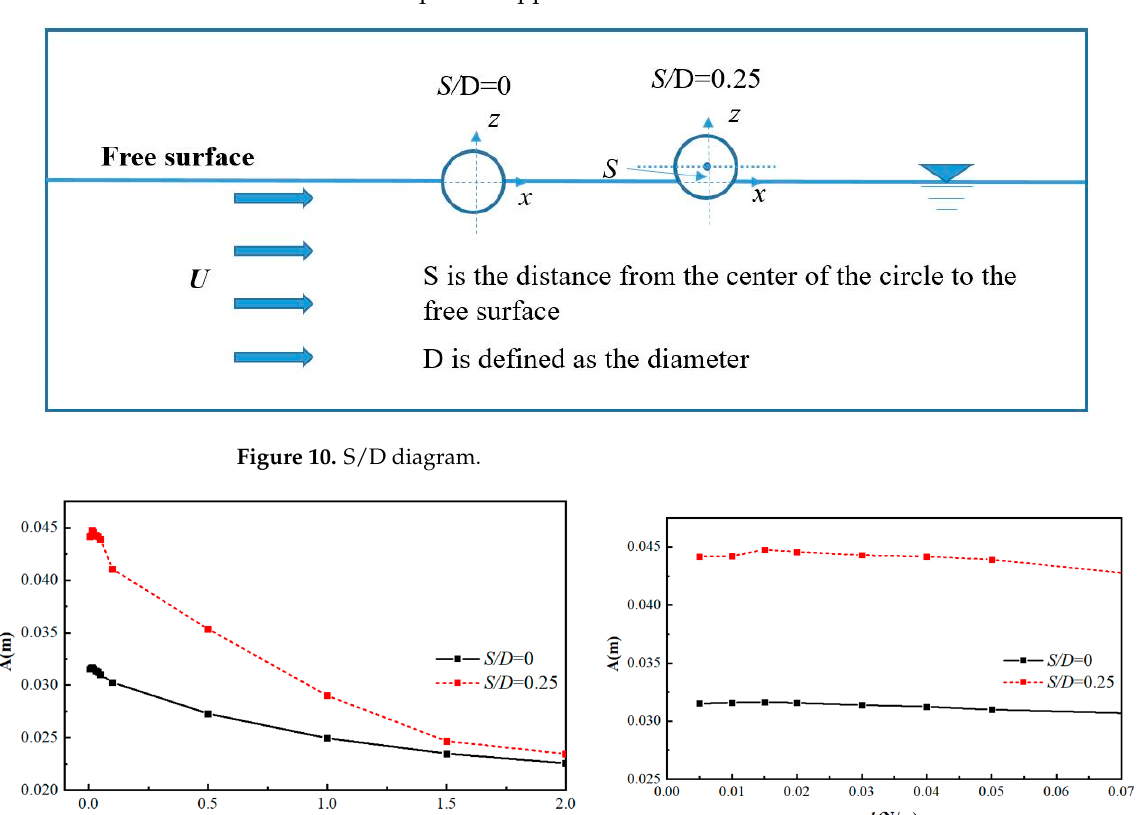
Figure 9. Vibration responses under different wave periods ( U r = 3.36, S/D = 0, A W = 0.0375 m).